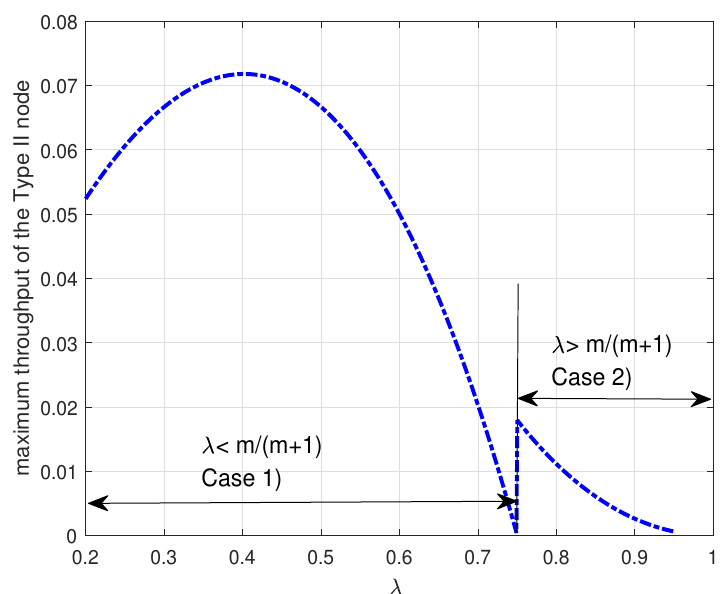
Figure 5. Maximum throughput T ∗ of the Type II node for Case (1) and Case (2) when m = 3. In this II figure, Case (1) represents the maximum throughput of the Type II node given by the Theorem 2 and Case (2) represents the maximum throughput of the Type II node given by the Theorem 3.